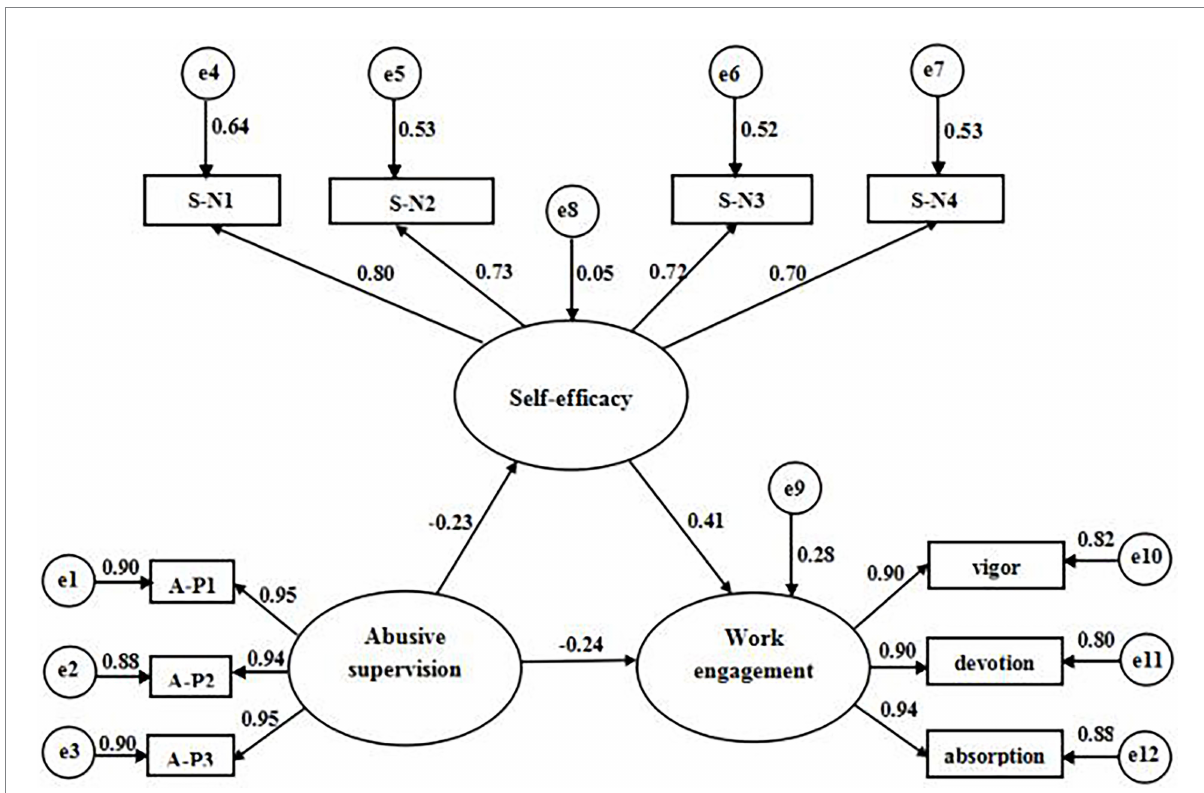
FIGURE 1 The study model with standardized path coefficients. Note 1. All coefficients were statistically significant ( p < 0.01). Note 2. A-P1, A-P2 and A-P3 = parceled items that make up the abusive supervision scale. S-N1, S-N2, S-N3, and S-N4 = parceled items that make up the self-efficacy